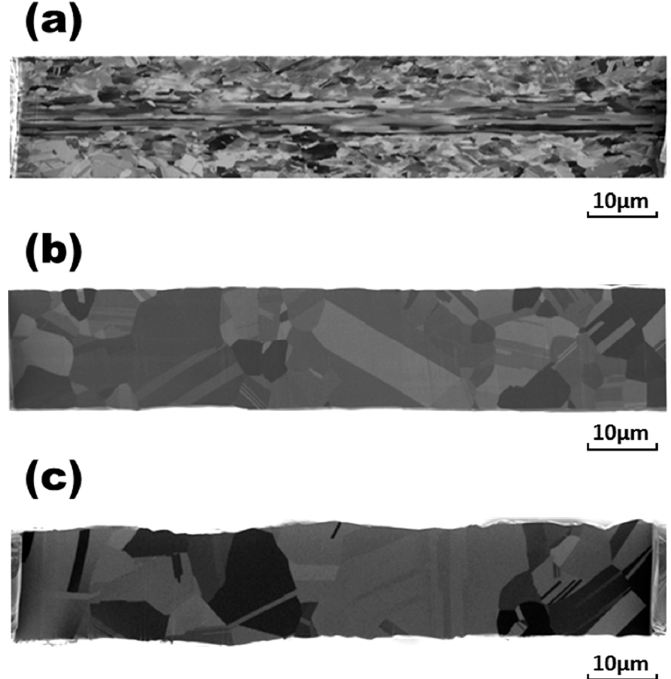
Figure 5. FIB image shows the grain structures in longitudinal cross ‐ sections of the Ag ‐ 15Au ‐ 3Pd wire after current stressing at 1.23 × 10 5 A/cm 2 for various times: ( a ) original; ( b ) 1 h; ( c ) 20 h.